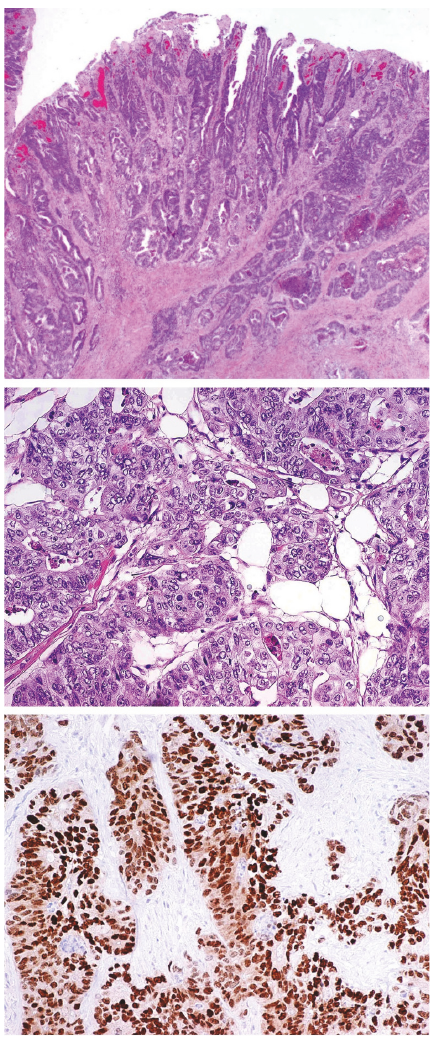
Figure 3: (a) Invasive colonic adenocarcinoma (20X Magnification).(b) Invasive colonic adenocarcinoma(200X Magnification). (c) Colonic adenocarcinoma showing epithelial expression of CDX2 (200X